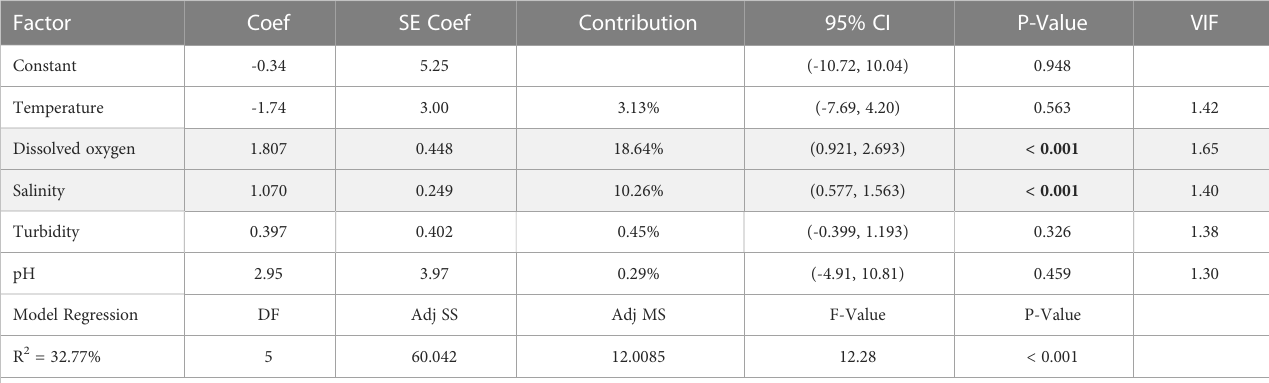
TABLE 3 Effect of measured estuarine parameters on C. tulipa spatfall.